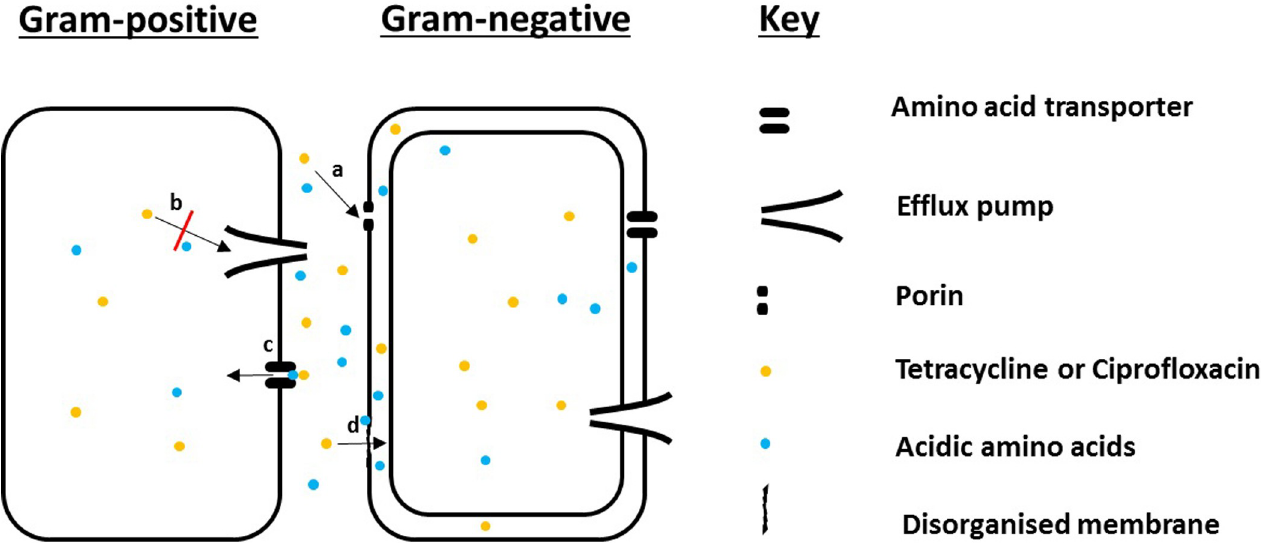
Fig 13. Diagram depicting possible mechanisms utilised by acidic amino acids in enhancing TC and Cip accumulation within both Gram-positive S . aureus (single membrane) and Gram-negative P . aeruginosa (two membranes). These mechanisms include a) charge triggered permeation through porins, b) efflux pump inhibition, c) permeation as ion-pairs through amino acid transporters and d) disorganisation of the outer membrane via chelation of otherwise stabilising cations such as Mg 2+ and Ca 2+ by acidic amino